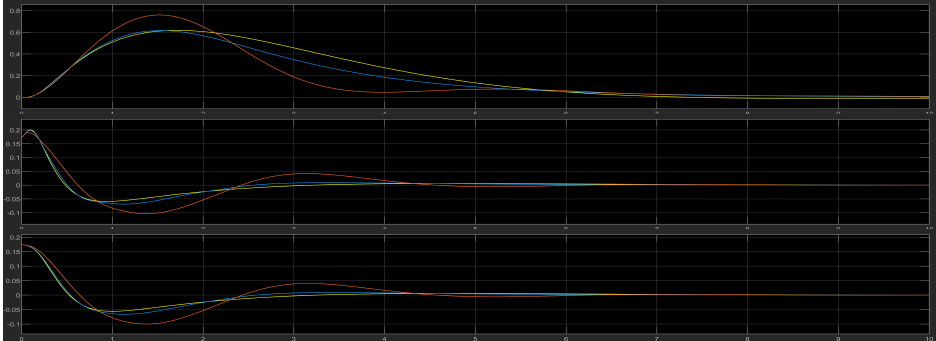
Figure 23. FLC (light blue), LQR (yellow), and modified FLC (orange).